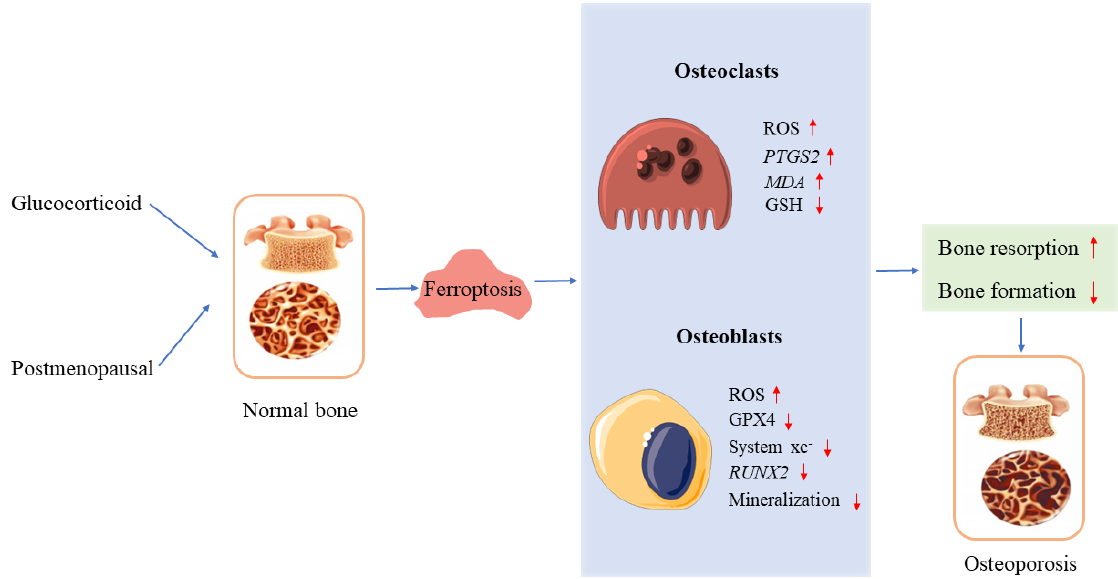
Figure 2. Ferroptosis and osteoporosis. In osteoclasts and osteoblasts, glucocorticoids and post- menopausal hormones induce ferroptosis, leading to osteoporosis. ↑ increase, ↓